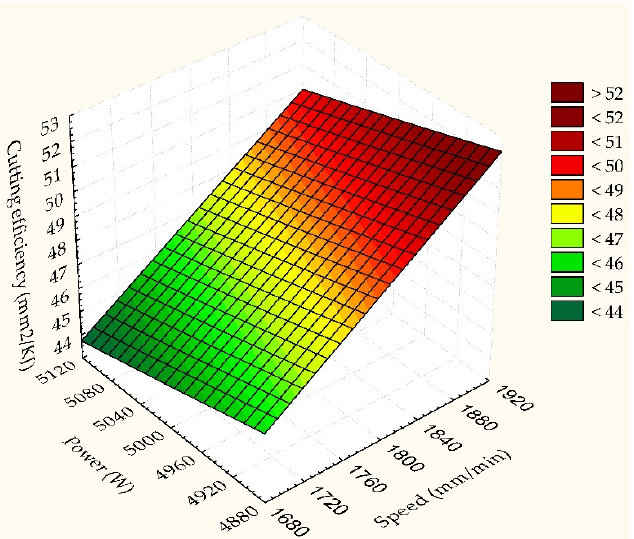
Figure 7. Linear dependence of cutting efficiency as a function of speed and laser